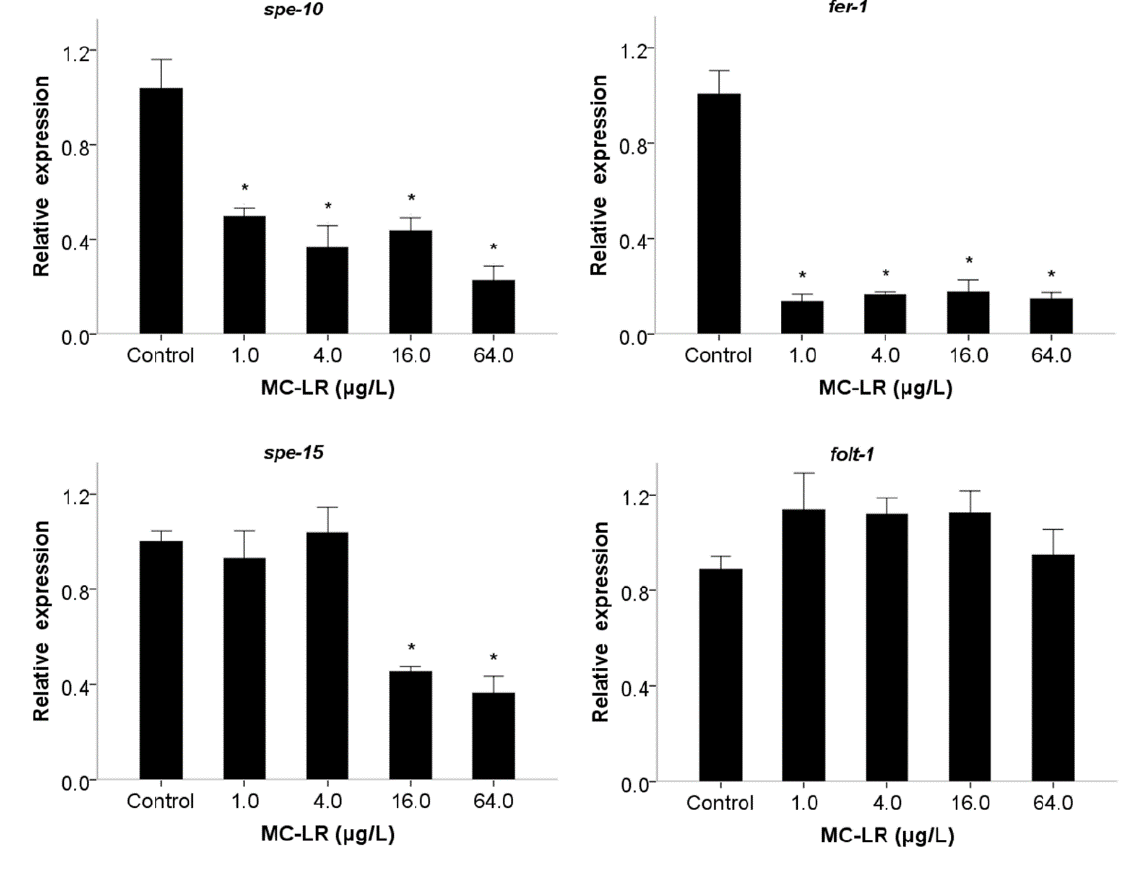
Figure 6. Effects of MC-LR exposure on relative mRNA expression levels of genes involved in spermiogenesis. Bars represent means ± SEM. * p < 0.01 vs . the control